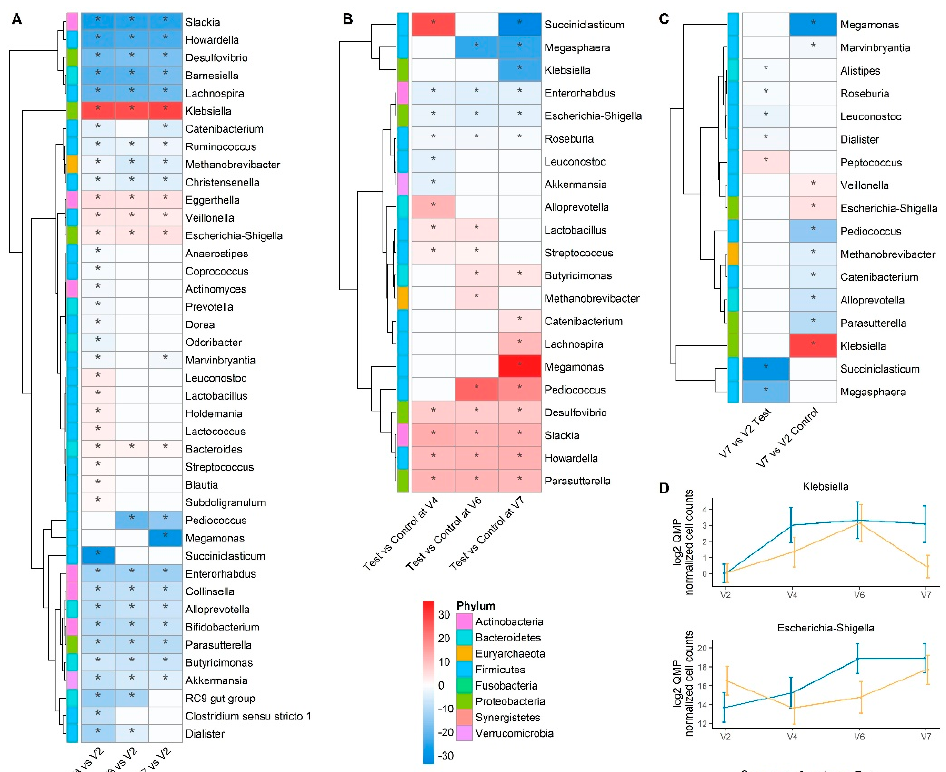
Figure 3. Genus-level differential analysis based on Quantitative Microbiome Profiling ( A ) Heatmap of differentially abundant genera between each visit and baseline (V2) in the Control group. Red indicates higher fold-change and blue lower fold-change with regards to baseline ( B ) Heatmap of differentially abundant genera between Test and Control groups at each visit. Red indicates a higher fold-change and blue a lower fold-change in Test group ( C ) Heatmap of differentially abundant genera between follow-up (V7) and baseline (V2) which behave differently in the two groups. Red indicates higher fold-change and blue lower fold-change with regards to baseline (V2). For all heatmaps, only taxonomically assigned genera were selected based on QMP normalized counts >10.000.000, (FDR adj. * p < 0.1, DESeq2-based Wald test). Non-significant fold changes were set to zero for heatmap display and significant fold changes are highlighted by a star. ( D ) Quantitative log 2 abundance of Escherichia/Shigella and Klebsiella in response to Hp treatment along the study, as mean ± 95%